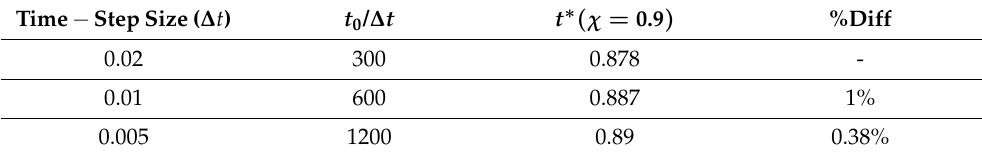
Table 3. Time-step independence study.